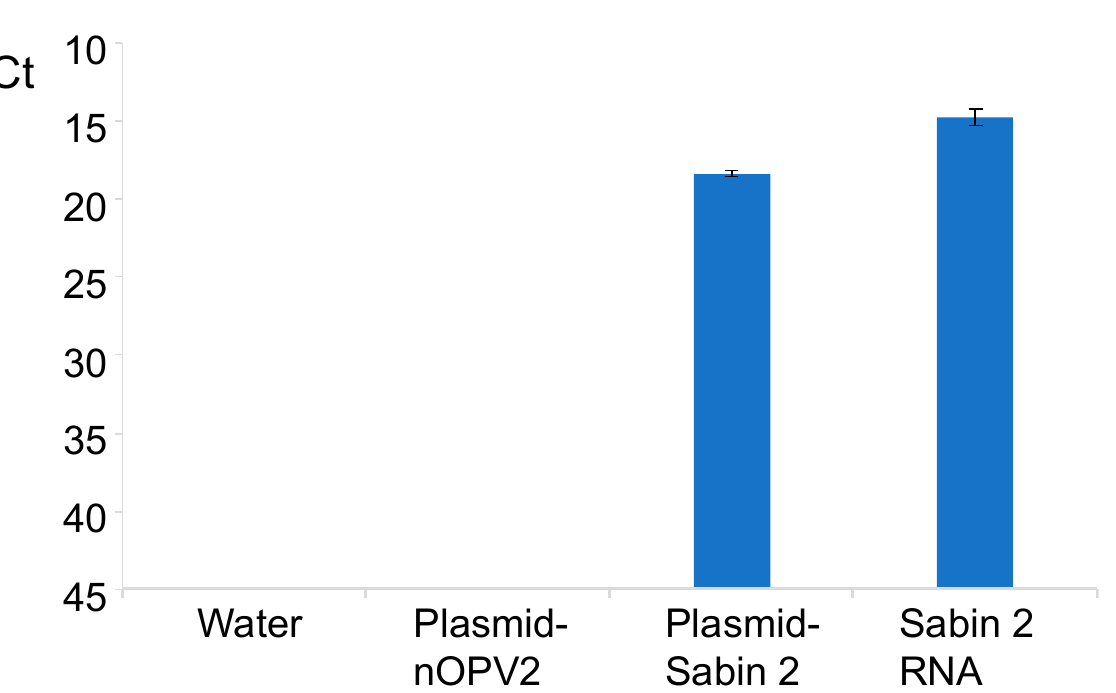
Figure 2. The three repeats of qosRT-PCR analysis (each repeat is presented in one line) of RNA diluted samples: RNA was extracted from Sabin 2 virus (with titer of 8.34 Log 10 CCID 50 /mL), serially diluted 10-times using 10-fold steps and subjected to qosRT-PCR analysis. The R 2 is around 1 for each repeat of the analyzed samples.